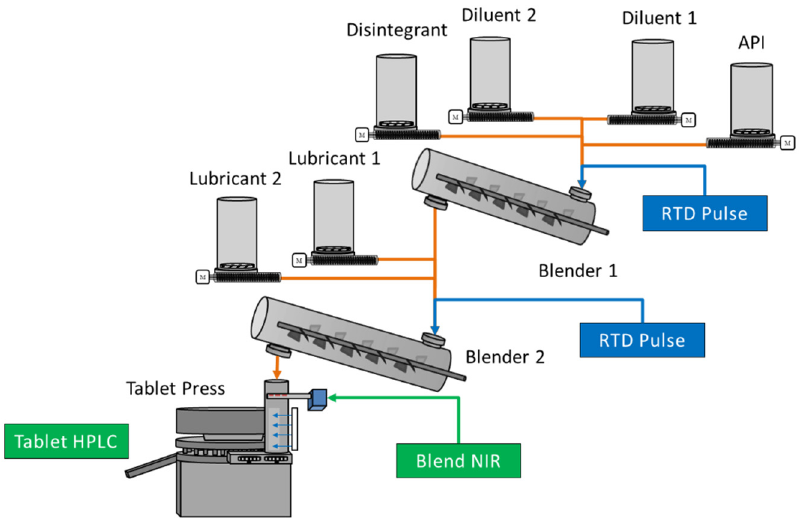
Figure 1. Process flow diagram of the GEA CDC-50 Rig.